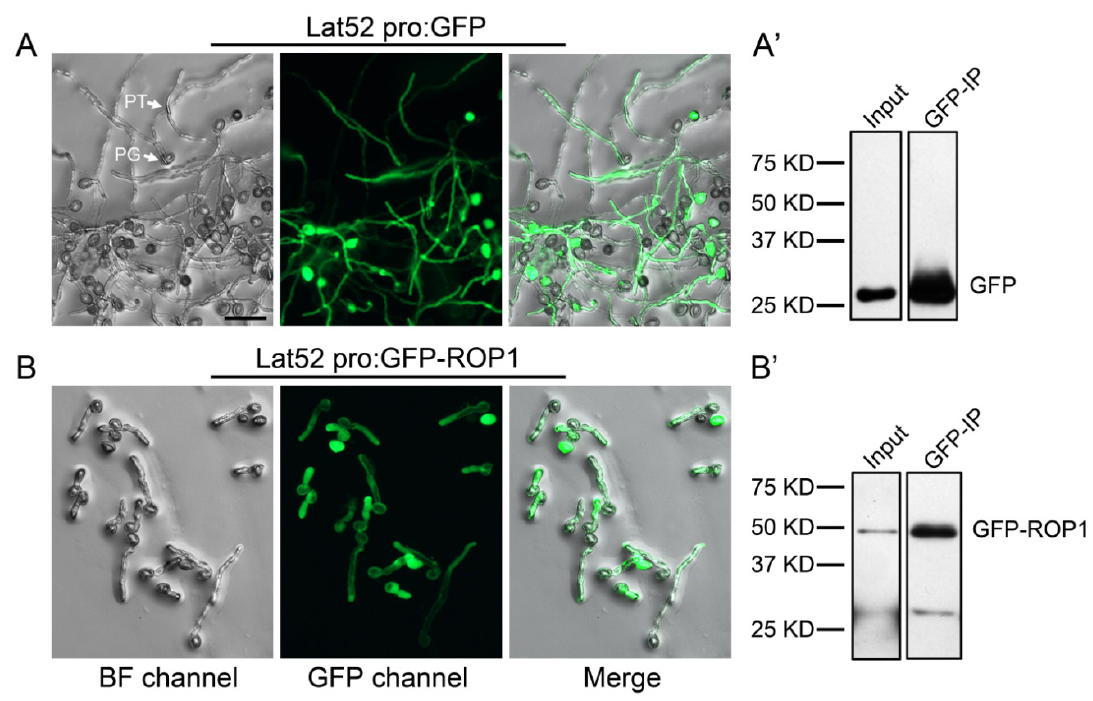
Figure 1. Pollen tubes of GFP (Green Fluorescence Protein) and GFP-ROP1 expressing transgenic lines. Mature pollen was collected from open flowers and cultivated on pollen germination medium for 4 h at 28 ◦ C. Tubes of GFP labeled showed tip and polar growth ( A ), but the GFP-ROP1 expressing pollen tubes showed slightly depolarized growth ( B ). GFP ( A’ ) or GFP-ROP1 ( B’ ) proteins were precipitated from pollen tubes of the two transgenic line using GFP-Trap beads and were detected by Western blot using the anti-GFP